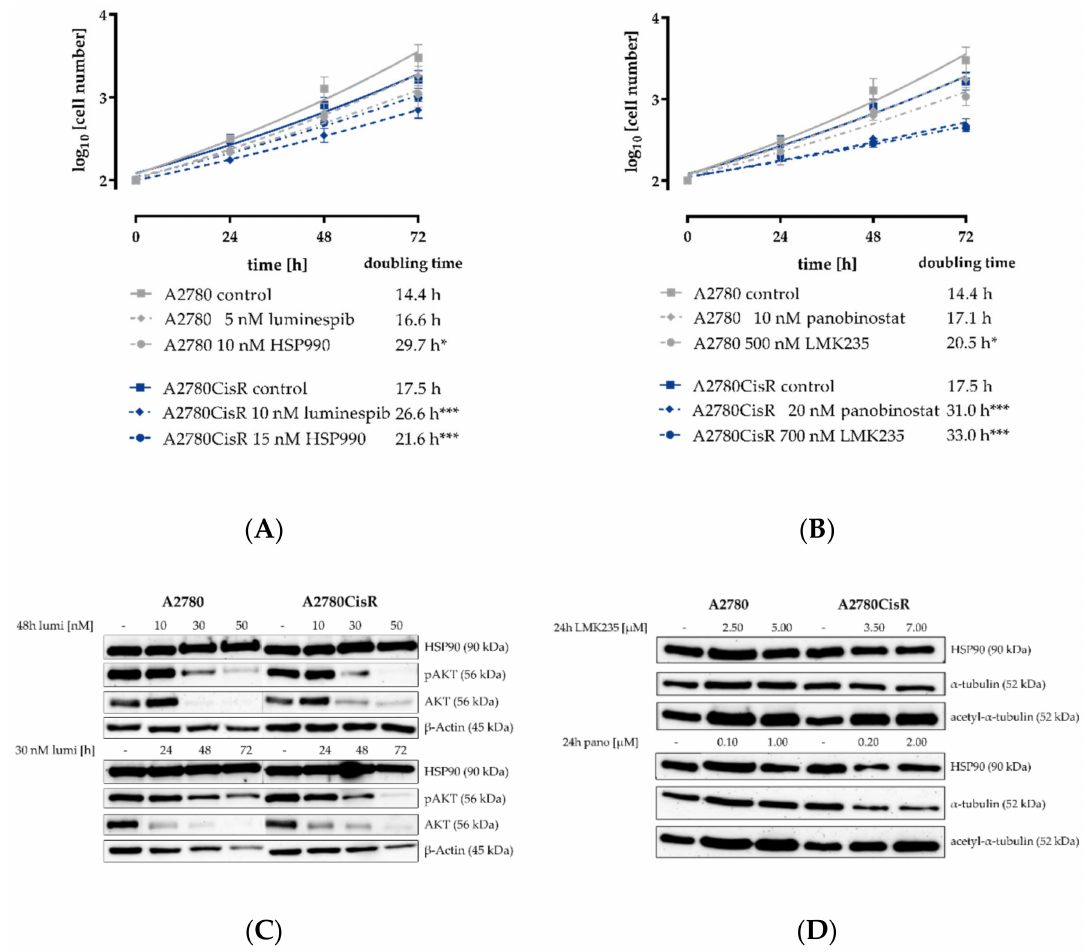
Figure 1. E ff ects of HSP90i and HDACi on cell growth and protein expression in A2780 and A2780CisR cells. ( A ) A 72 h incubation with the HSP90i luminespib and HSP990 showed a slight decrease in cell proliferation for A2780CisR cells. In A2780, this e ff ect was only achieved with HSP990. ( B ) A 72 h incubation with the HDACi panobinostat or LMK235 slightly reduced the cellular growth of A2780 and A2780CisR cells. ( C ) A 48 h incubation with luminespib with IC 50 , three-fold IC 50 and five-fold IC 50 or time-dependent incubation with three-fold IC 50 of luminespib led to a decrease in the expression of the HSP90 client protein AKT and its phosphorylation (pAKT). The uncropped and labeled immunoblots are shown in Figure S1. ( D ) A 24 h incubation with panobinostat or LMK235 increased the acetylation of α -tubulin in both cell lines. Data shown are mean ± SEM of three independent experiments or one representative immunoblot out of three. Statistical analysis was performed using t-test. Levels of significance: * p ≤ 0.05, *** p ≤